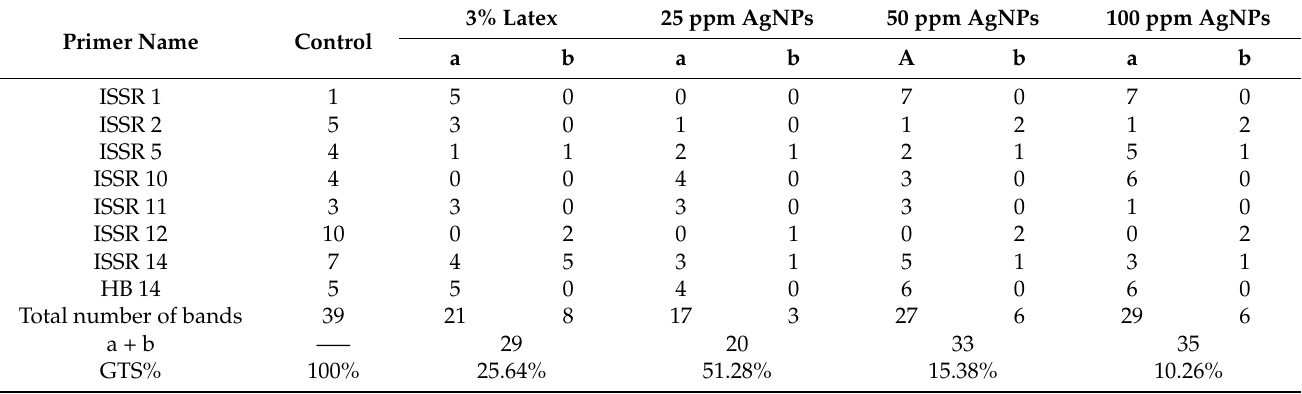
Table 5. Effect of 3% C. acutum crude latex and different concentrations of its silver nanoparticles on ISSR profiles of V. faba and GTS% of the treated V. faba . a: refers to appearance of new bands, b: disappearance of normal bands and a + b: number of polymorphic